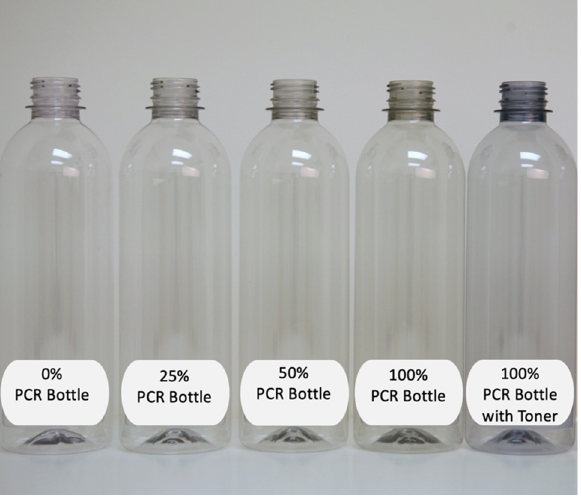
Figure 17. Impact on color with increasing PCR level (image courtesy of Amcor).